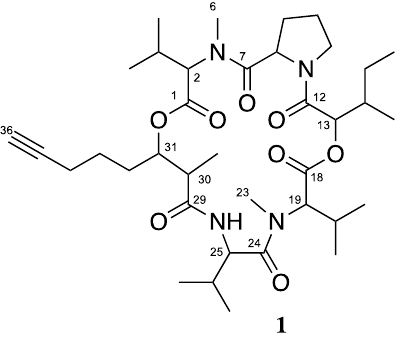
Figure 11. Structure of compound veraguamide C ( 1 ).